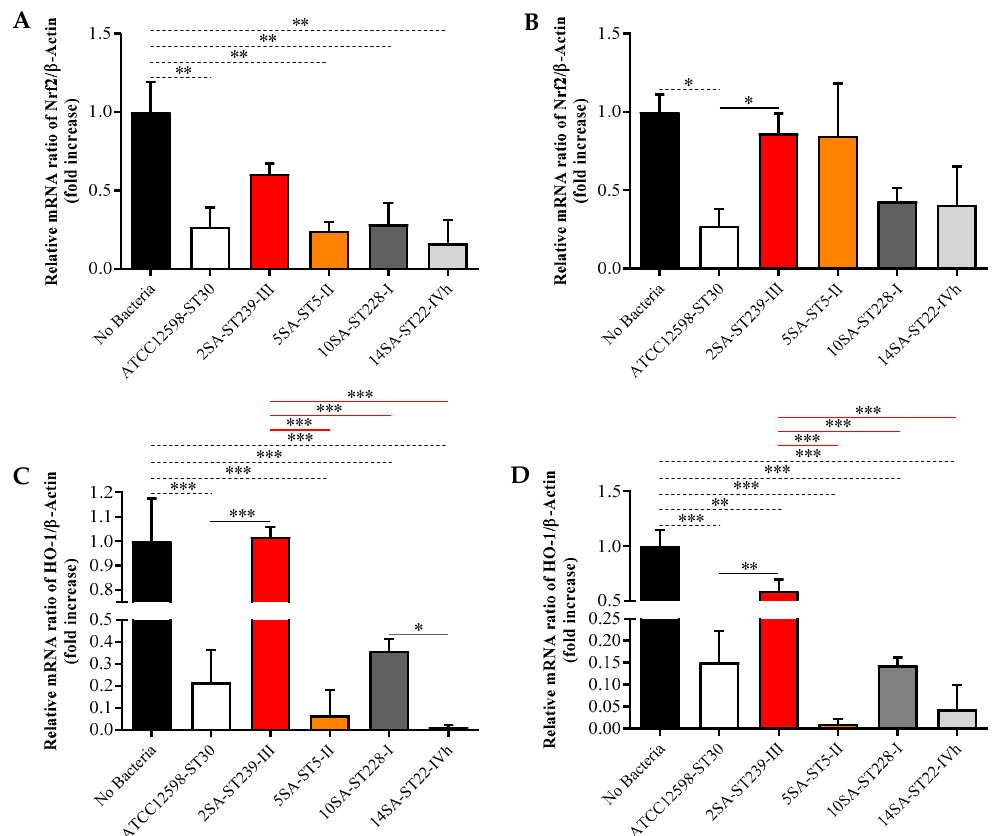
Figure 6. Gene expression of nuclear factor E2-related factor 2 (Nrf2) ( A , B ) and heme oxygenase 1 (HO-1) ( C , D ) in uninfected (No Bacteria) MG-63 osteoblast-like cells and in MG-63 cells infected at an MOI of 100:1 with five different S. aureus strains detected at 3 and 24 h. The abundance of each mRNA is expressed relative to the abundance of β -actin-mRNA. Values are means ± SD of three independent experiments. Significant comparisons between each experimental condition are indicated by lines. * Significantly different, p < 0.05; ** significantly different, p < 0.01; *** significantly different, p < 0.001.